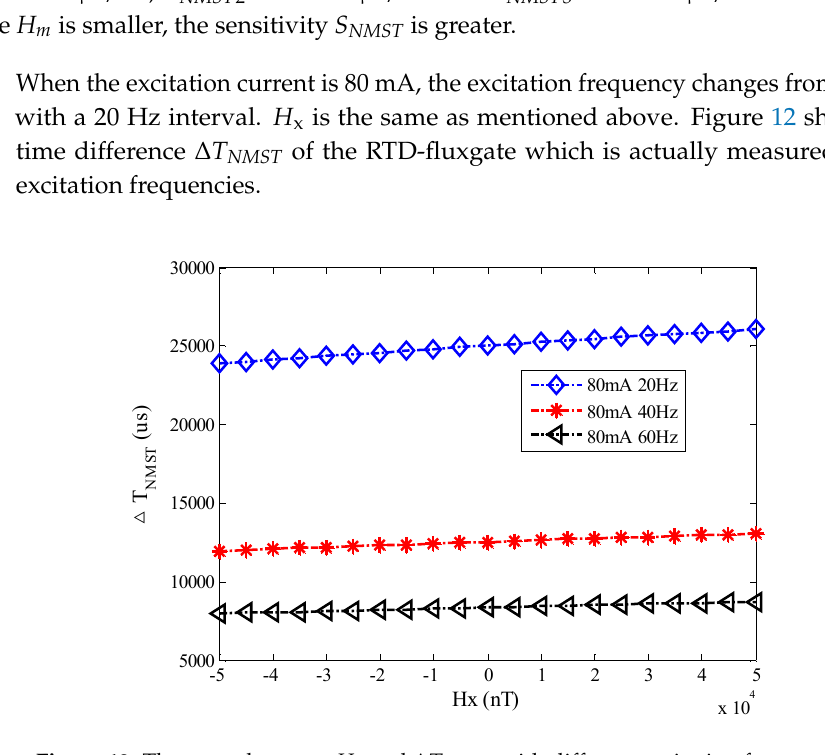
Figure 13. The fluctuation of Δ T NMST by using the NMST readout scheme.